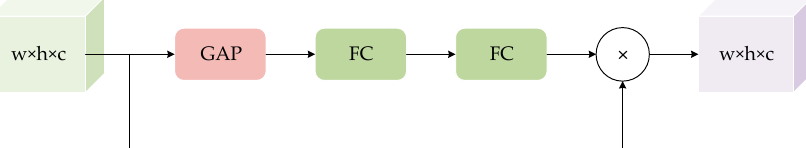
Figure 1. The structure of the SE block. w, h, and c denote the width, height, and channel of a feature map, respectively. ’GAP’ is the average-pooling operation along the weight and height axes. ‘FC’ represents a fully connected layer with an activation function.